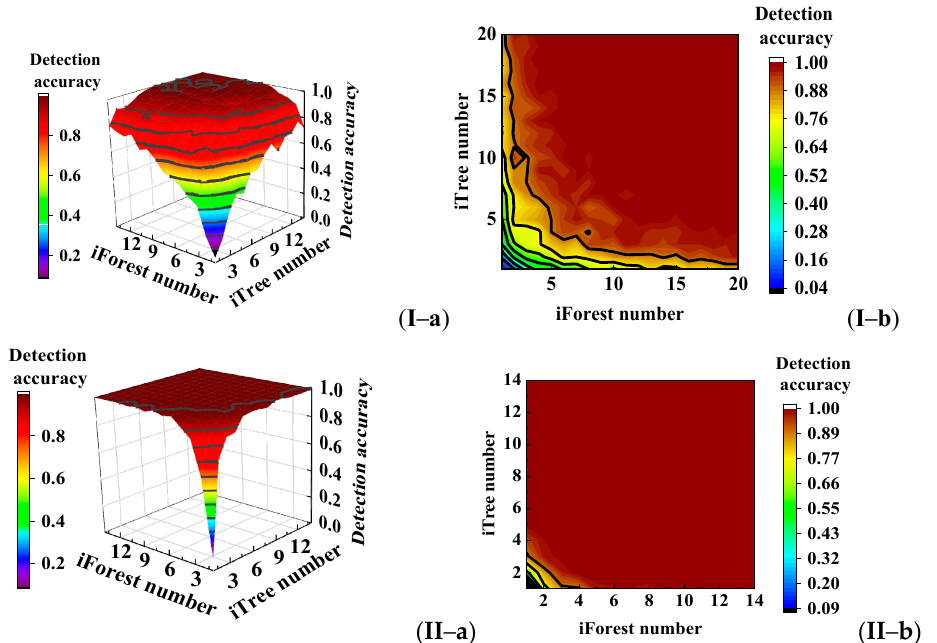
Figure 14. Detection accuracy of the proposal under different values of N f and N t . ( I ) AHFNS. ( II ) AHFS. ( a ) Three-dimensional map. ( b ) Top view two-dimensional